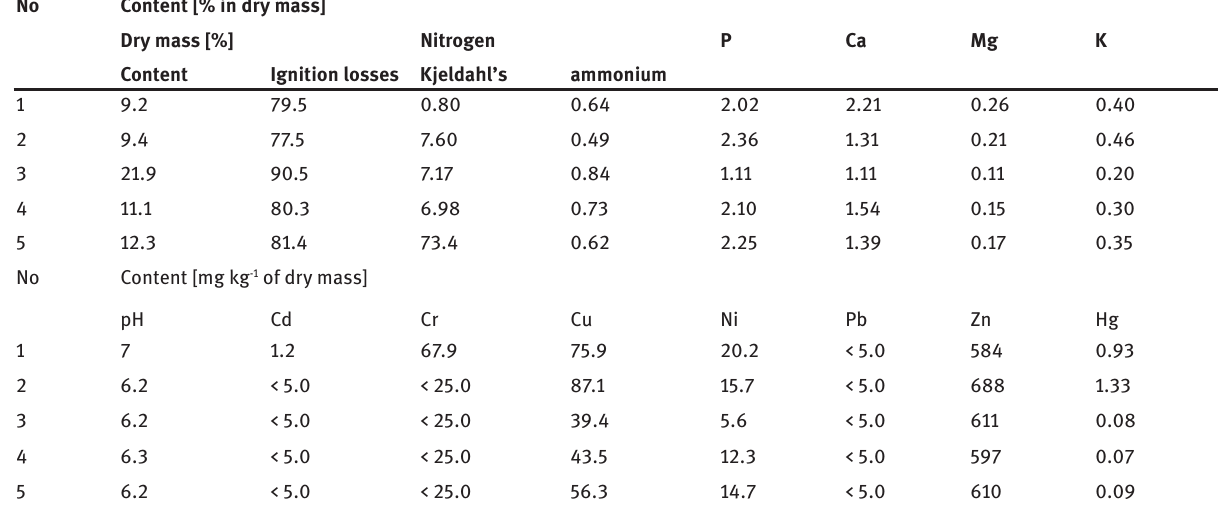
Table 7: Composition of industrial post-filtration